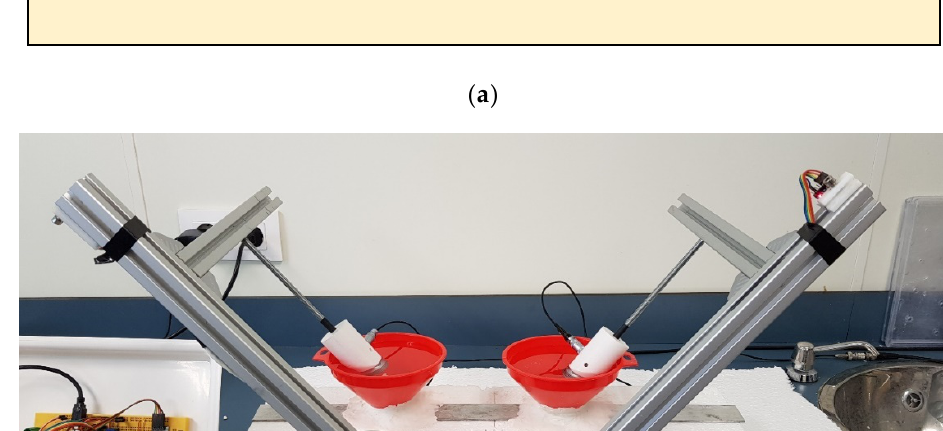
◦ ◦ and 40 , for the same frequency range ◦ ◦ and A 0 with 40 , since the coupling